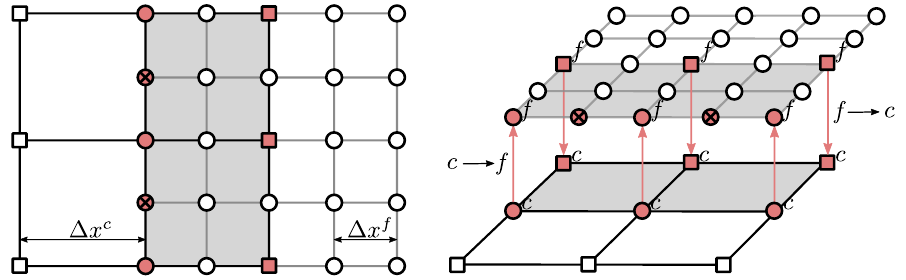
Figure 3. Grid transition interface for two-dimensional cell-vertex layout, : regular fine node, : fine interface node with co-located coarse partner, : hanging middle node, : regular coarse node, : coarse interface node with co-located fine